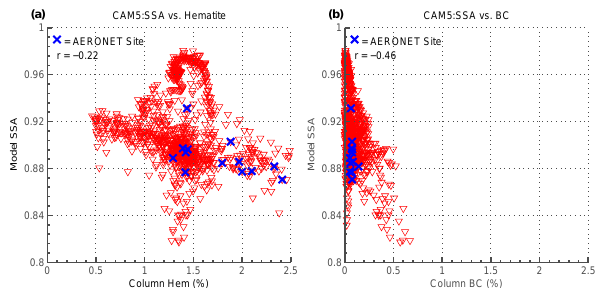
Figure 11. Model single scattering albedo from CAM5 with min- eralogy is compared to total percent column hematite (a) and total percent column black carbon (b) . The locations of AERONET sites used in the comparison in Fig. 9 are plotted in blue. hematite inclusion for an internal dust mixture is twice the value in this study. For both CAM4 and CAM5 simulations with mineralogy, the hematite content in the soil distribu- tions is 1.4 % by mass, or 0.7 % by volume, while the tuned dust assumes 0.8 % hematite by mass, or 0.4 % by volume. For the case with 1.5 % hematite by volume, they report TOA forcing efficiency which is too cooling compared to the clear-sky RFE reported by Li et al. (2004), while the simulated surface RFE matched observations. From this, the atmospheric heating efficiency was underestimated. The